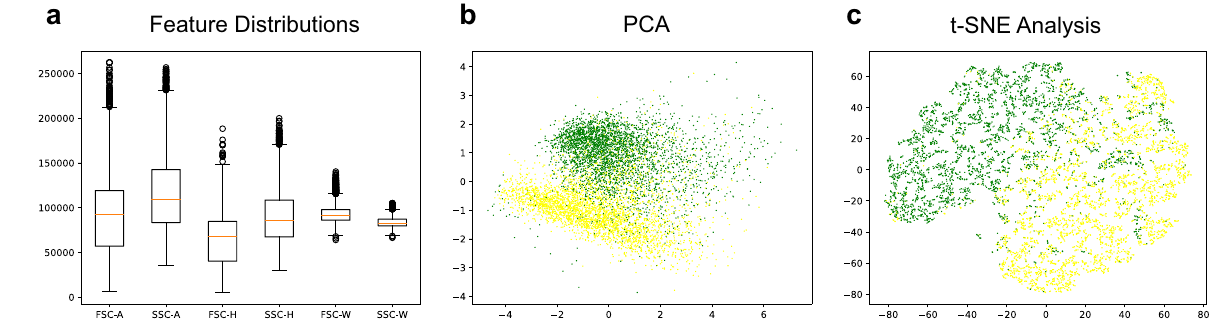
Fig. 1 Descriptive statistics and visualization of the training data. a Box and whisker plot of the training dataset. The means of the six features (FSC-A, SSC-A, FSC-H, SSC-H, FSC-W, and SSC-W) were comparable, with the maximal ratio less than 2.0-fold (mean SSC-A /mean FSC-H = 1.81). b Visualization of six-dimensional training dataset (green: live cells, yellow: apoptotic cells) using PCA (principal component analysis). c Visualization of the six-dimensional training dataset (green: live cells, yellow: apoptotic cells) using t-SNE (t-distributed stochastic neighbor